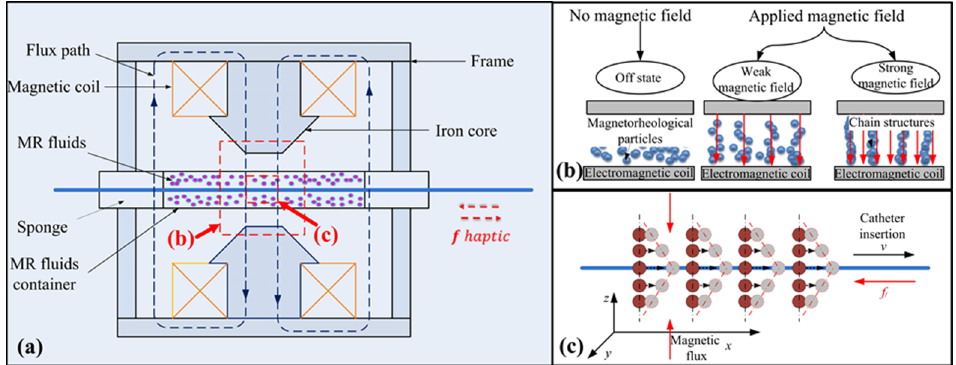
Figure 2. ( a ) Schematic of the MR-based master haptic device. ( b ) The magnetic field characteristic of magnetorheological particles. ( c ) The process of haptic generation in the case of the magnetic field.